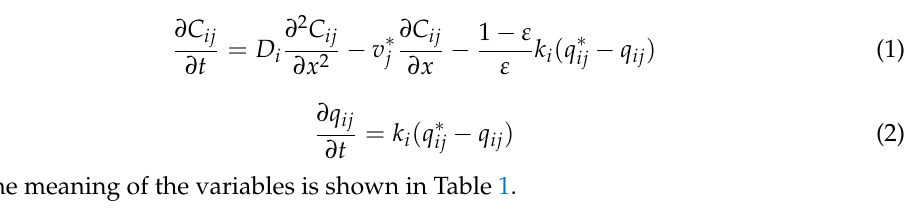
Table 1. Meanings of the variables of the SMB